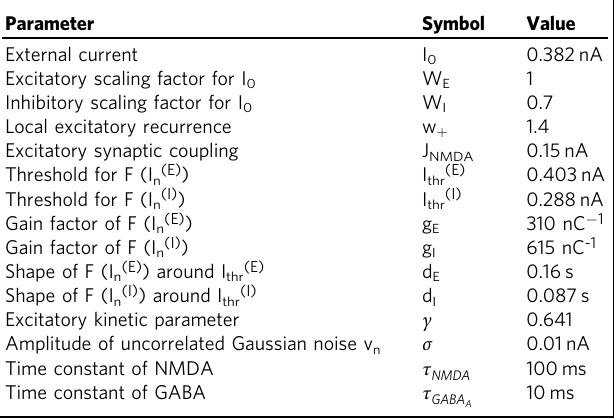
Table 3 Dynamic Mean Field model